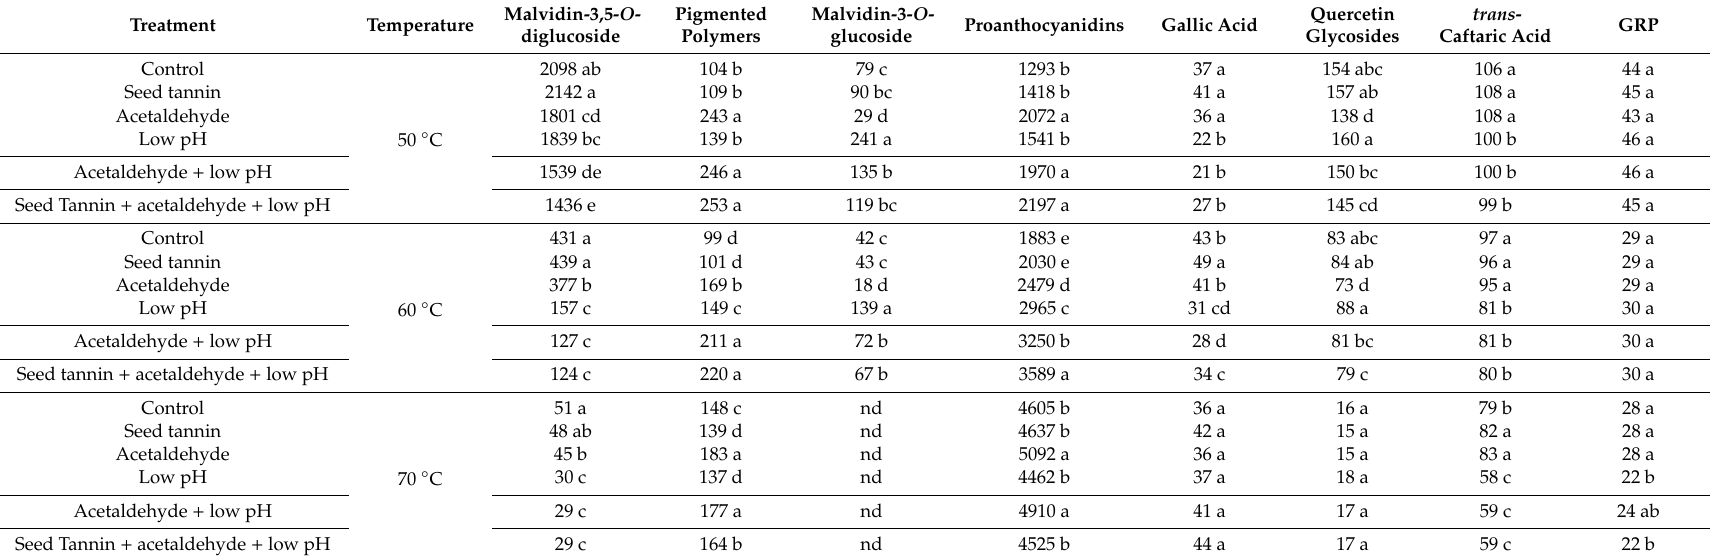
Table 4. Comparison of phenolic compounds (mg / L, normalized to 68 ◦ Brix) in concentrate derived from flash d é tente (FD) after nine days of accelerated aging at di ff erent